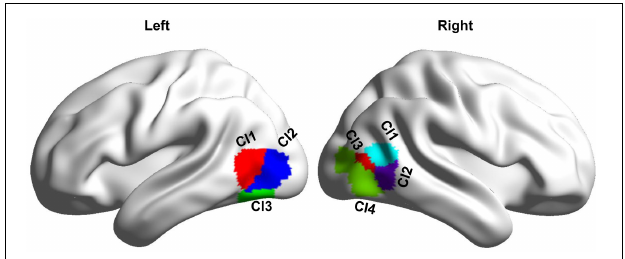
FIGURE 1 | Definition of the bilateral MT subregions based on a recent MT atlas created by coactivation-based parcellation. Left MT is parcellated into three subregions, and right MT is parcellated into four subregions.